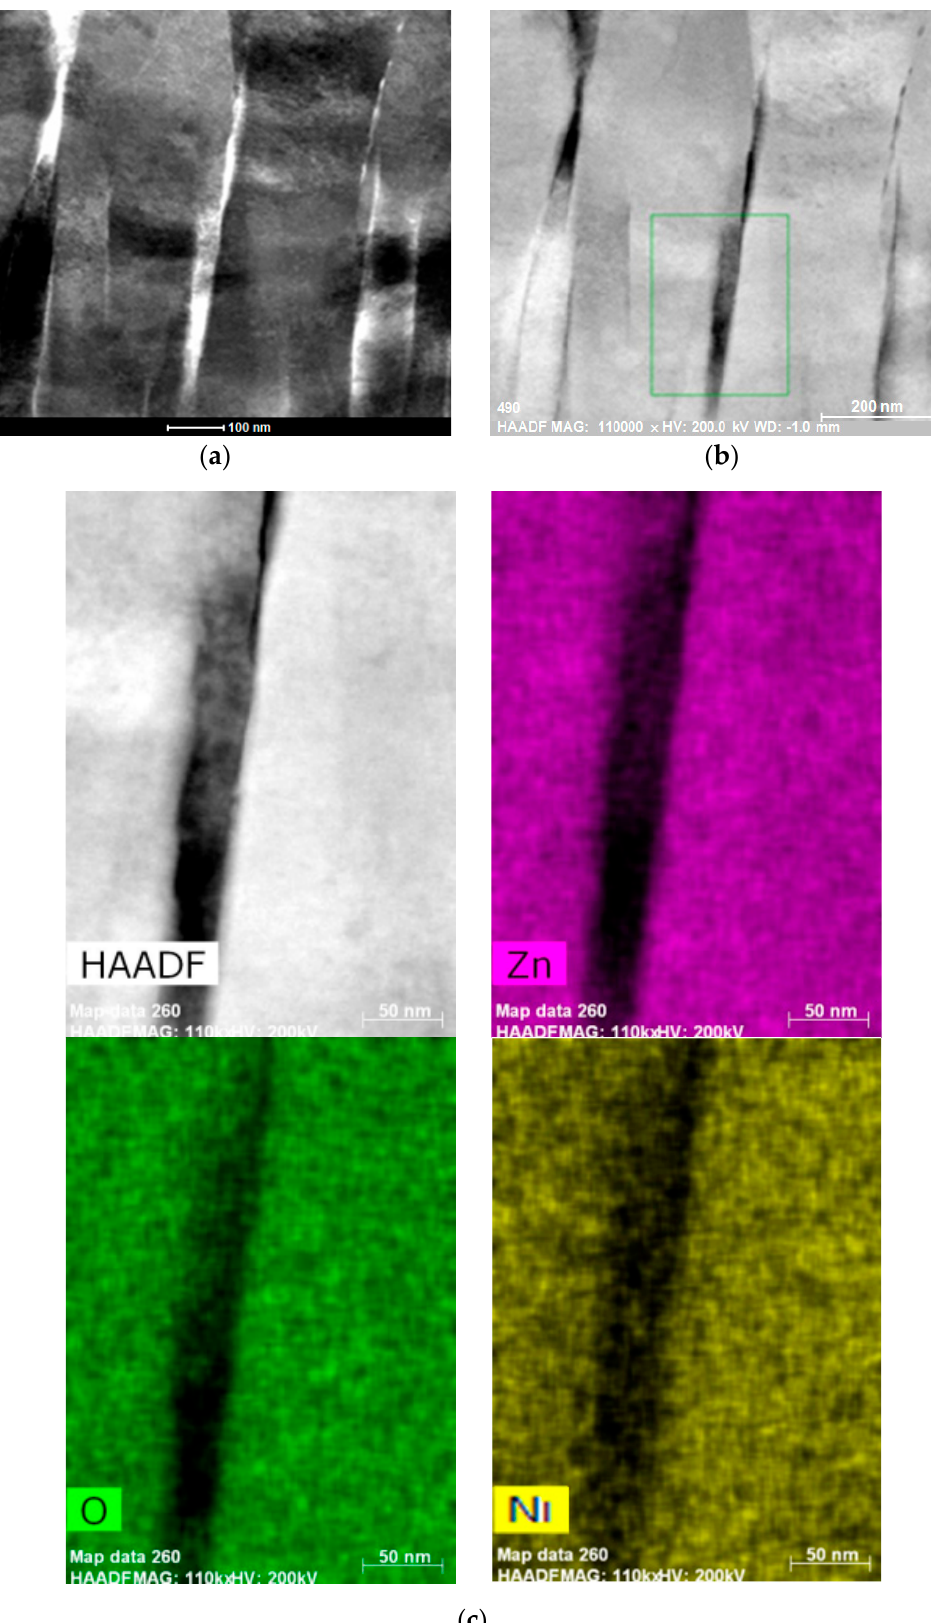
Figure 3. ( a ) STEM BF and STEM HAADF (Z–kontrast); ( b ) images of Zn 0.96 Ni 0.04 O thin films; ( c ) EDX analysis confirms the presence of nickel in the ZnO matrix in the selected area.